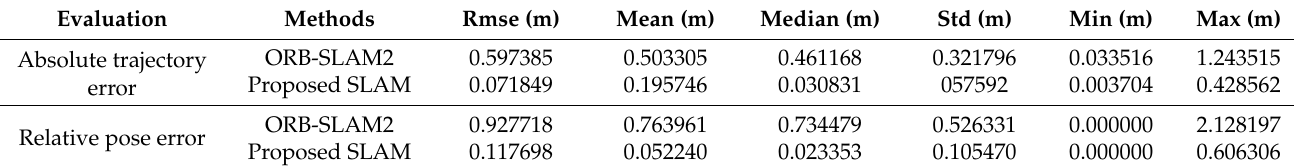
Table 7. Pose error representative value of dataset